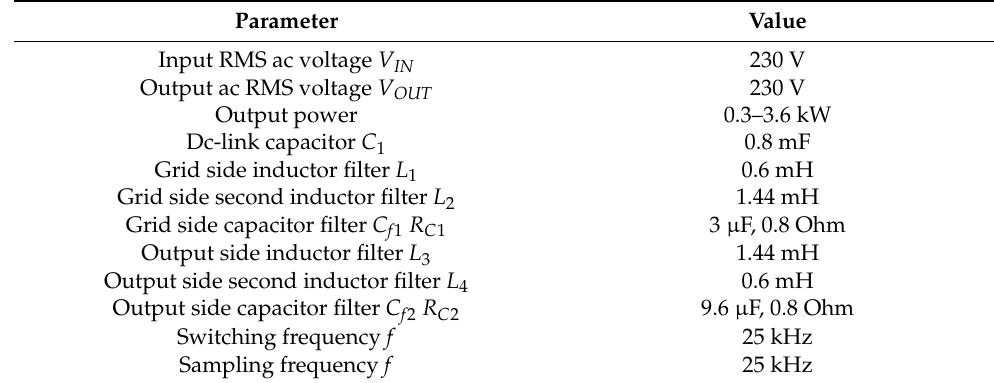
Table 1. Components and parameters of the